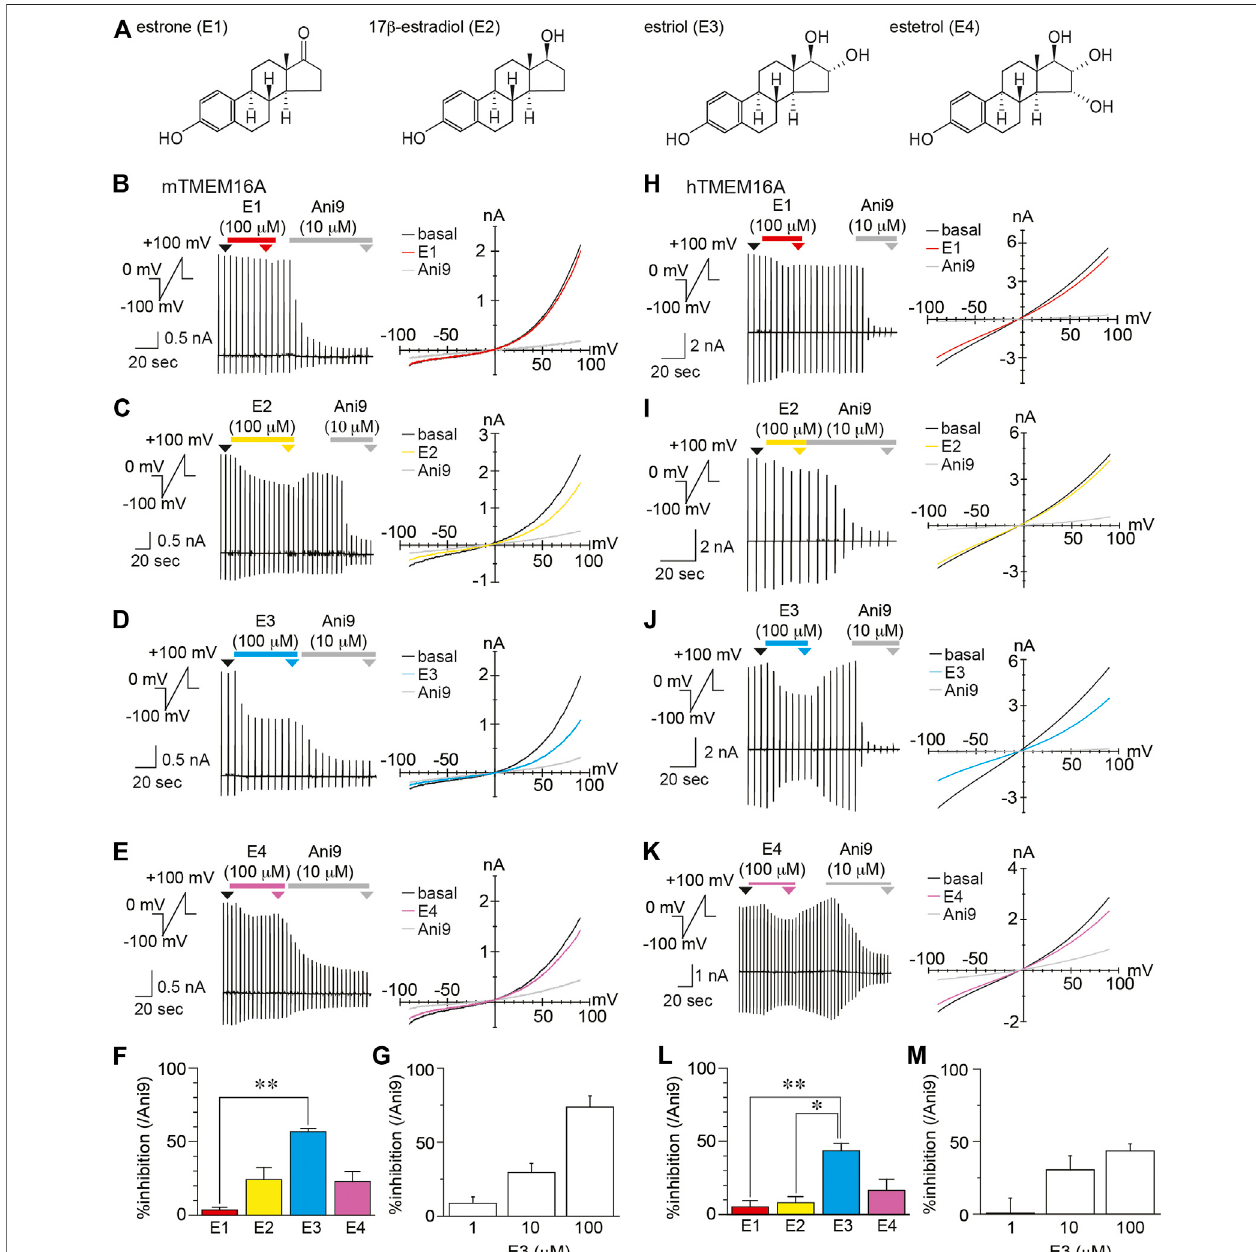
FIGURE 4 | The inhibitory effects of estrogen on TMEM16A (A) Chemical structures of estrogen (B – E) Typical traces (left) and current-voltage curves (right) of chloridecurrentsinHEK293TcellsexpressingmTMEM16Aduringapplicationofestrone(E1) (B) ,17 β -estradiol(E2) (C) ,estriol(E3) (D), andestetrol(E4) (E) .Theholding potentialwas0 mV,andramppulses( − 100to+100 mV,300 ms)wereappliedevery5s.BasalmTMEM16Acurrentswereinducedby100 nMintracellularfreecalcium. Typical current-voltage curves at the time indicated by black (basal), red (E1), yellow (E2), cyan (E3), violet (E4), and gray (Ani9) arrowheads (F) The percentage of inhibitioncausedby100µMestrogenat+60 mV(n (cid:2) 5 – 6cells) (G) Thepercentage ofinhibitioncausedby1,10,and100µM E3at+60 mV(n (cid:2) 5 cells).Dataareshown as mean ± SEM. ** p < 0.01, Kruskal-wallis ANOVA (H – K) Typical traces (left) and current-voltage curves (right) of chloride currents in HEK293T cells expressing hTMEM16AduringapplicationofE1 (H) ,E2 (I) ,E3 (J), andE4 (K) .Theholdingpotentialwas0 mV,andramppulses( − 100to+100 mV,300 ms)wereappliedevery5 s. BasalhTMEM16Acurrentswereinducedwith300 nMintracellularfreecalcium.Typicalcurrent-voltagecurvesatthetimeindicatedbyblack(basal),red(E1),yellow(E2), cyan (E3), violet (E4), and gray (Ani9) arrowheads (L) The percentage of inhibition caused by 100 µM estrogen at +60 mV (n (cid:2) 5 cells) (M) The percentage of inhibition caused by 1, 10, and 100 µM E3 at +60 mV (n (cid:2) 3 – 5 cells). Data are shown as the mean ± SEM; ** p < 0.01, * p < 0.05, Kruskal-wallis ANOVA.